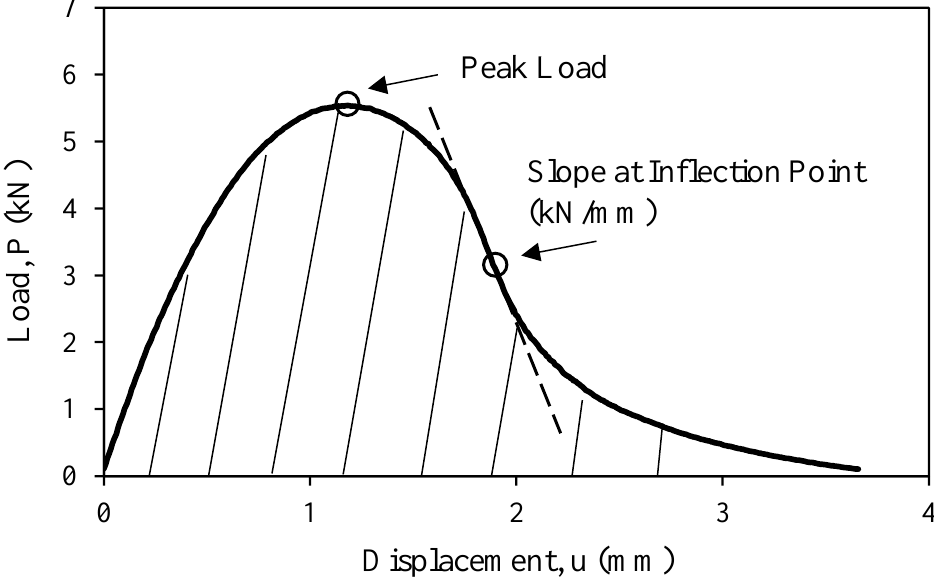
Figure 5. Typical load–displacement curve from the SCB test.